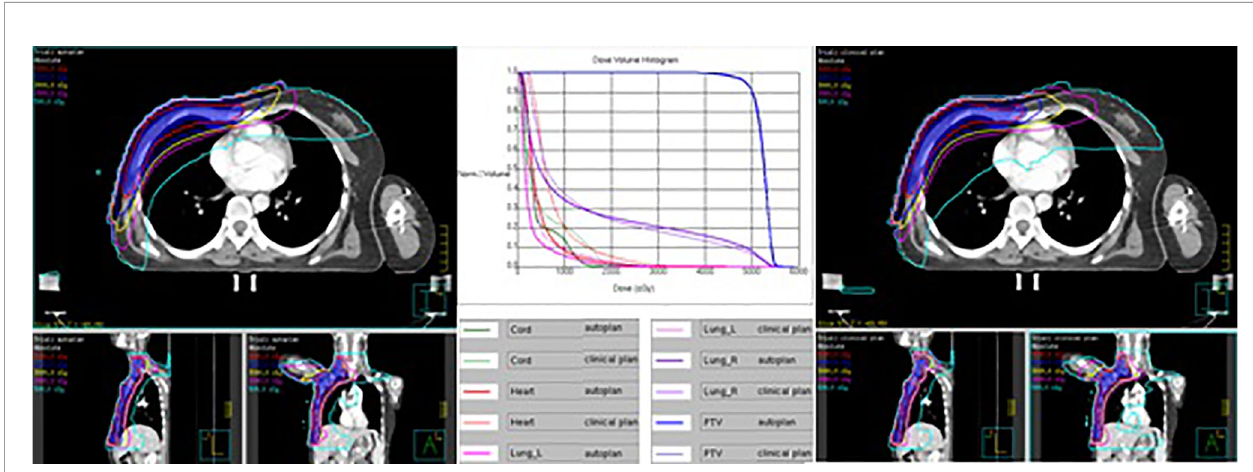
FIGURE 2 | Dose distribution and DVH for autoplan (left) and clinical plan (right) of 1 right-sided PMRT case. The blue colorwash area is PTV. The medium solid lines are isodose lines.